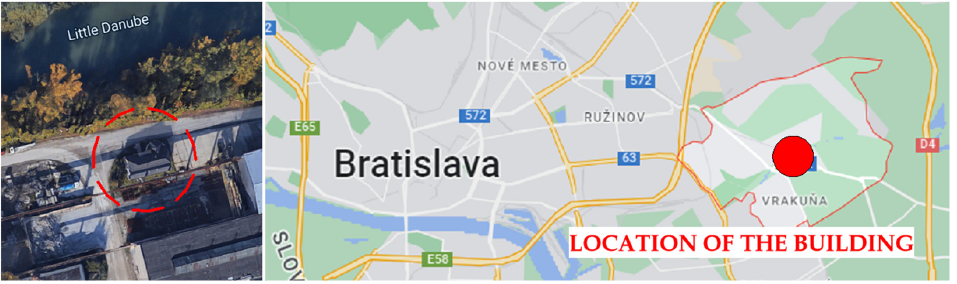
Figure 27. Location of the prototype of the prefabricated house IDA I within Bratislava, Slovak Republic. (https://www.google.com/maps (accessed on 20 June 2022)).